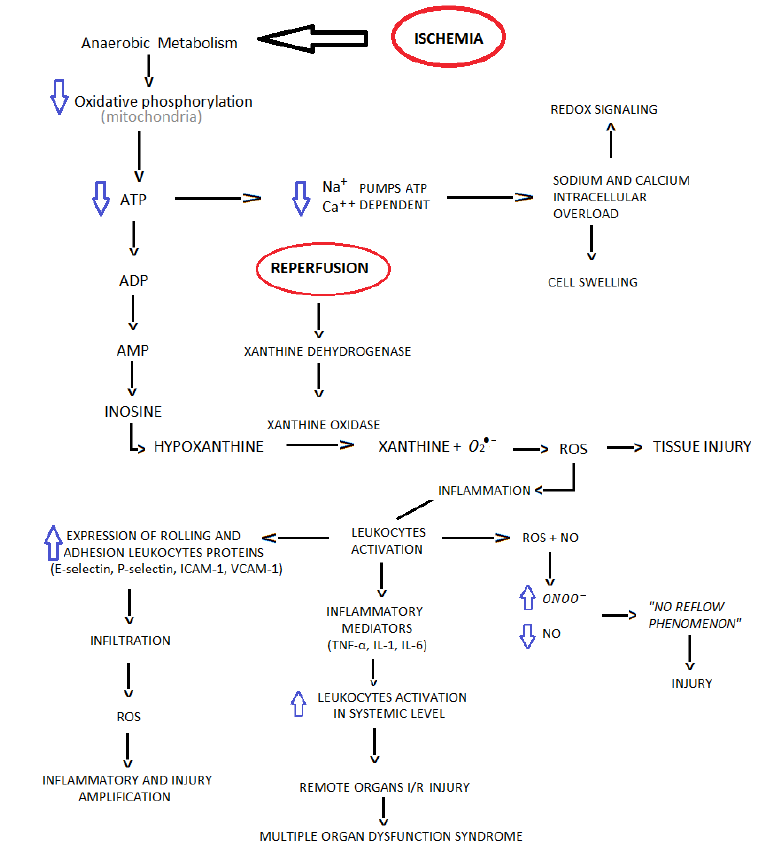
Fig. 1 – Mechanism of ischemia-reperfusion and oxidative